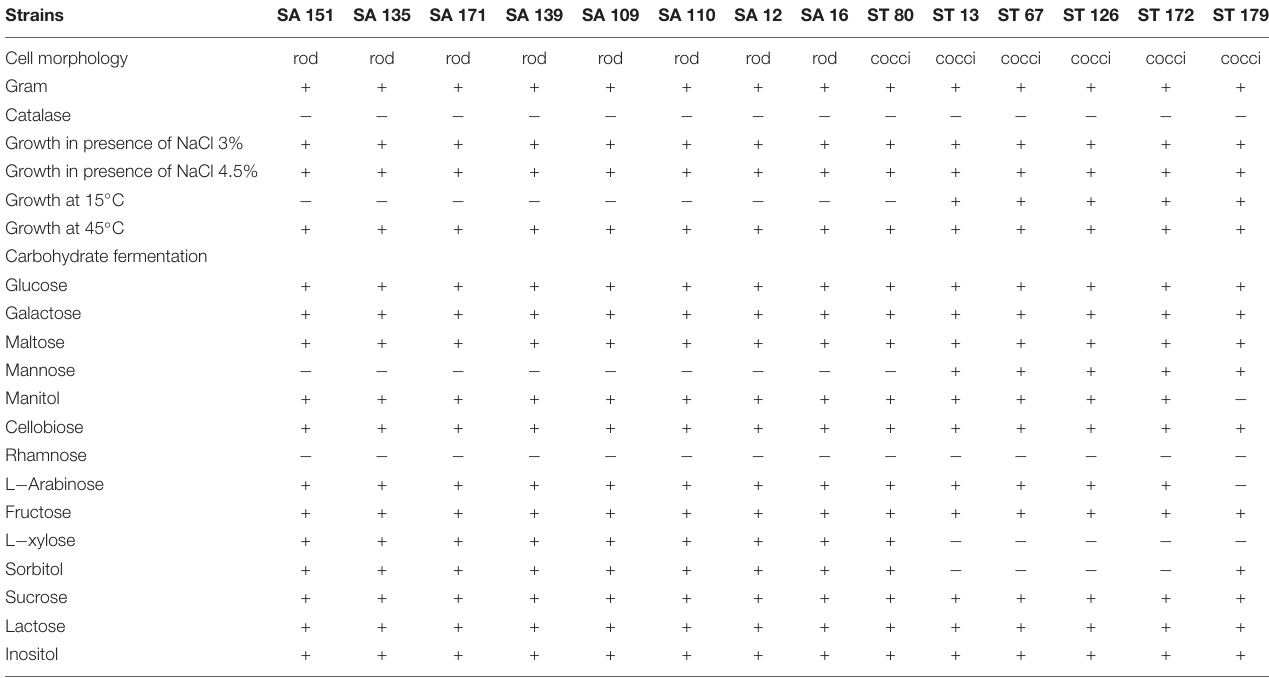
TABLE 1 | Results of the morphological and biochemical tests carried out for selected isolates. Strains